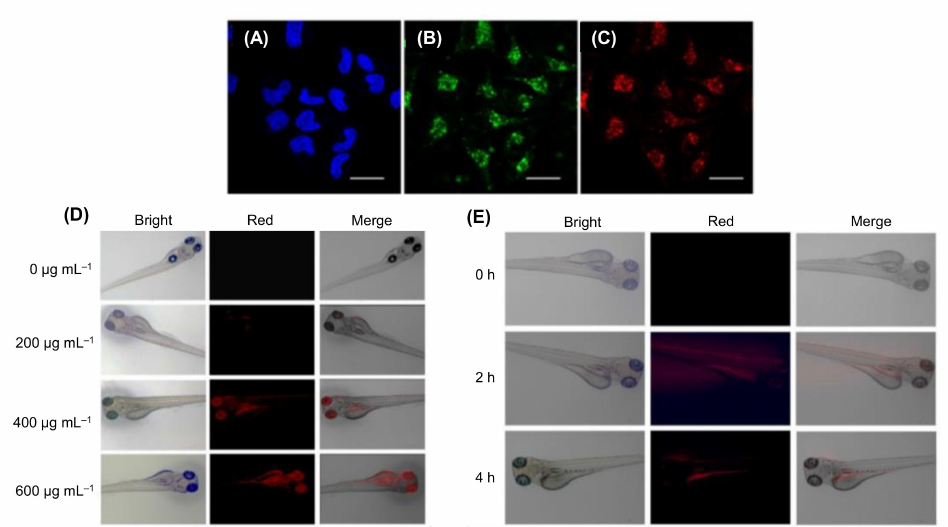
Figure 23. ( A ) Blue, ( B ) green, and ( C ) red emission of Ru-CDs for the bioimaging of HeLa cells. ( D ) Bioimaging results, and ( E ) fluorescence intensities of zebrafish embryos. Reprinted from [292], with permission from American Chemical Society,